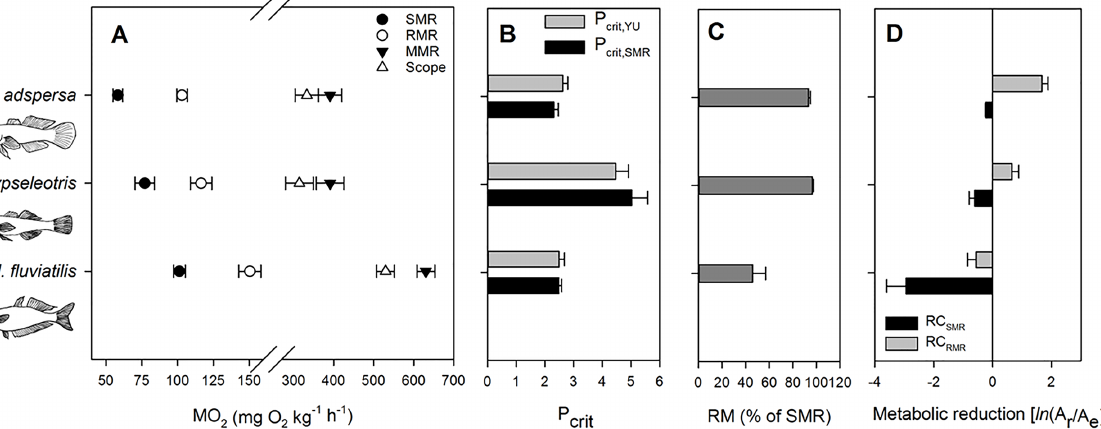
Fig 2. Physiological resistance to hypoxia for three fishes occupying different positions along the fast-slow lifestyle continuum. Melanotaenia fluviatilis , Hypseleotris sp. and Mogurnda adspersa have, respectively, a fast, intermediate and slow lifestyle (Table 1). (A) The gradient in standard (SMR), routine (RMR) and maximum (MMR) metabolic rates, as well as aerobic scope (AS). (B) Critical oxygen tensions (P crit s). (C) Magnitude of metabolic reduction. (D) Capacity for metabolic reduction (RC) is the logarithm of the ratio of two areas ( ln (A r /A e )), where A r is the area between either SMR (RC SMR ) or RMR (RC RMR ) and the depressed metabolic rate curves, during gradual hypoxia, and A e is EPHOC. Means and single standard errors are presented in all plots. Sample sizes for M . fluviatilis , Hypseleotris and M . adspersa were, respectively: A: N = 16, 16, 12; B: N = 8, 9 and 8; C and D: N = 6, 3 and